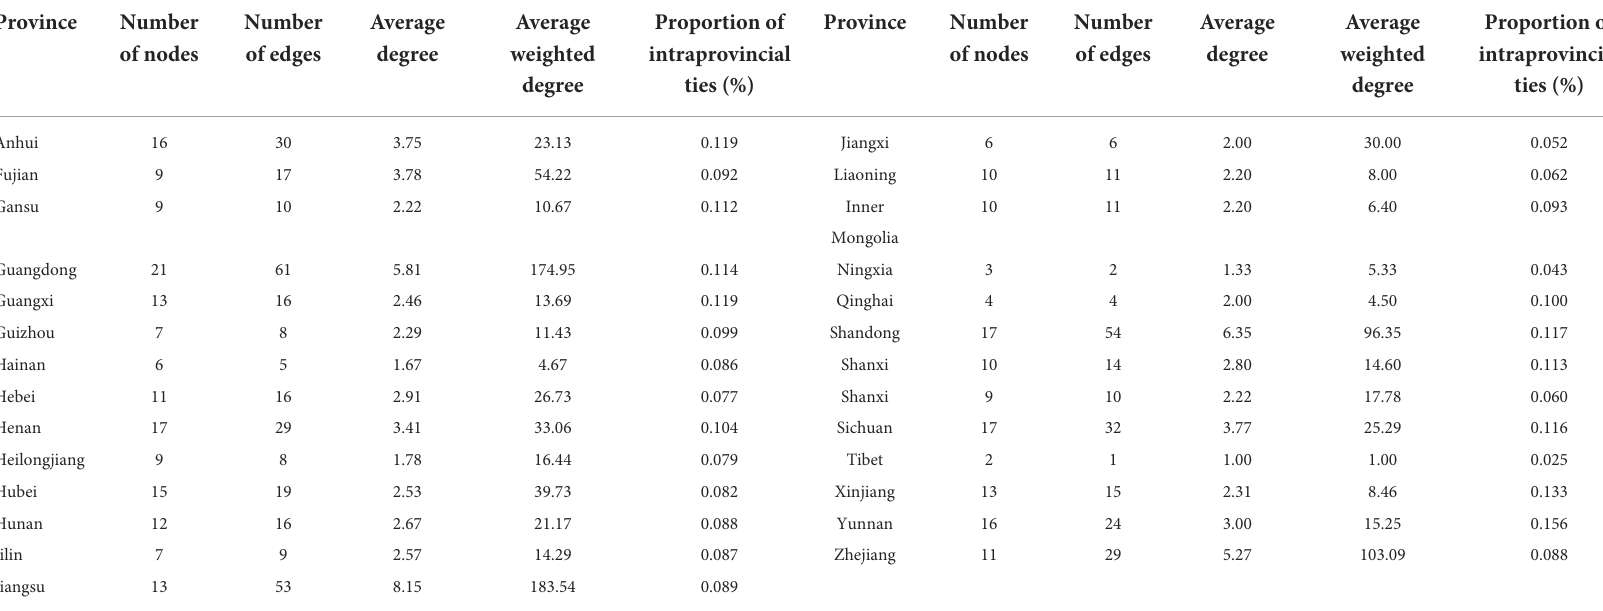
TABLE 7 Statistical characteristics of the intraprovincial urban biomedicine innovation networks of All Chinese Provinces in the 2016–2020 period. Province of